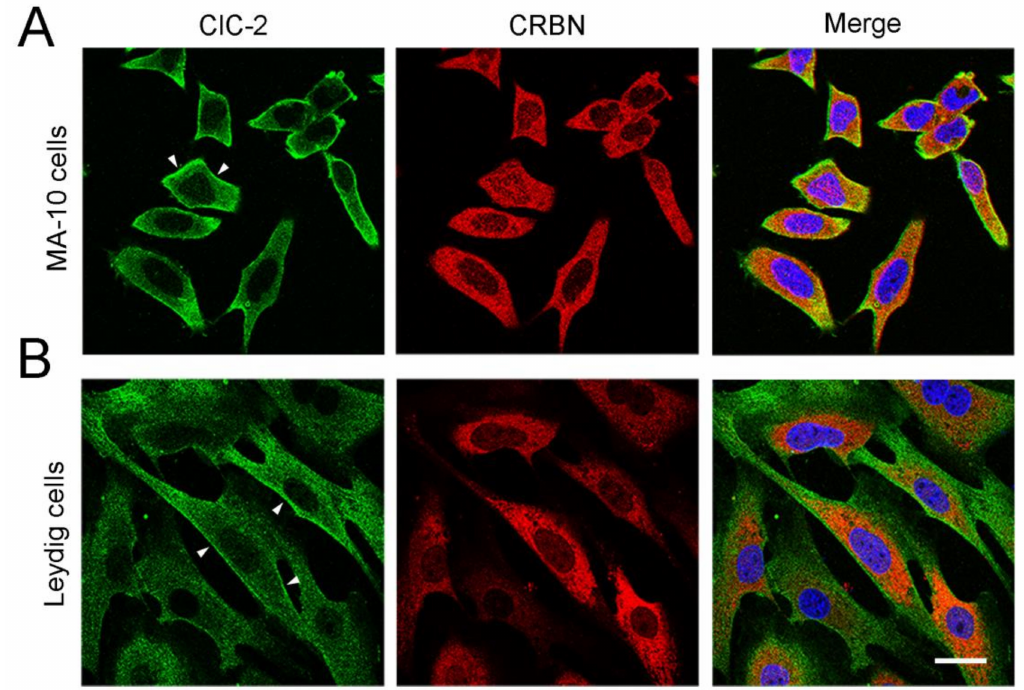
Figure 9. Subcellular localization of endogenous ClC-2 and CRBN. Representative confocal micrographs showing the immunofluorescence staining patterns of endogenous ClC-2 ( green ) and CRBN ( red ) in MA-10 cells ( A ) and cultured mouse Leydig cells ( B ). Merged images of ClC-2 and CRBN signals are shown in the rightmost panels, where cells were also stained with DAPI ( blue ) as a nuclear counterstain. Fixed cells were stained with the indicated antibodies under the permeabilized configuration. Arrowheads denote plasma membrane localization of ClC-2. Scale bar = 25 µ m. Data are representative of three independent